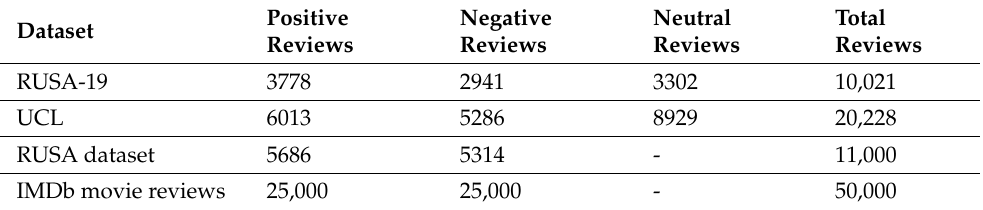
Table 2. Statistics of used datasets.